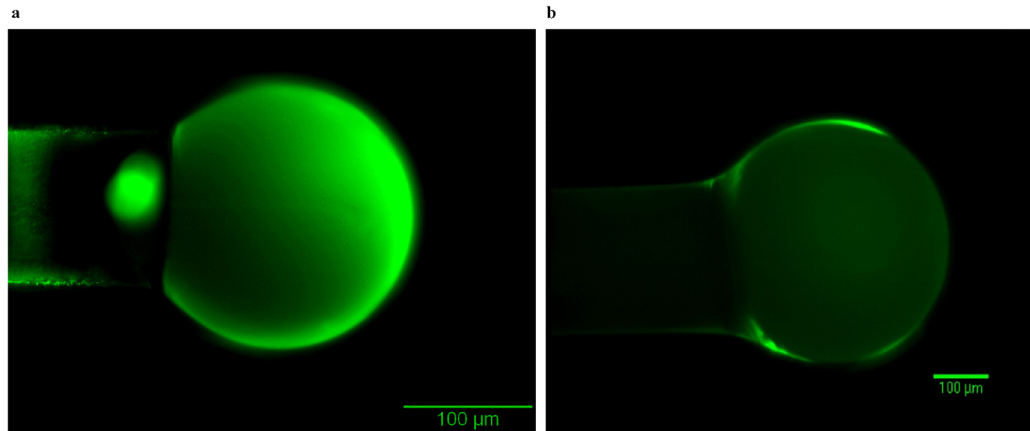
Figure 6. Dip coating methods applied to coat molecularly imprinted solution on the optical devices. ( a ) The result of the automated dip coating method, showing uneven saturation, and some microstructural damage (image from Dish 14 Sphere 30); ( b ) The result of the manual dip coating method shows uniform coating around the device (image taken from Dish 20 Sphere 4).